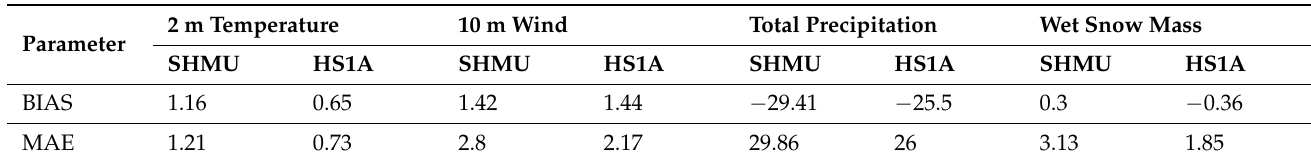
Table 7. Evaluation of forecast errors of the ALADIN/SHMU and ALADIN/HS1A model runs for